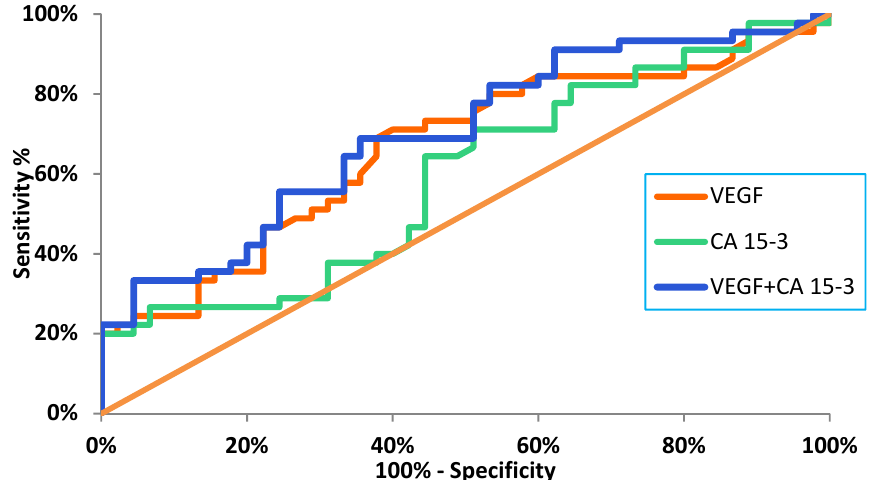
Figure 5. Diagnostic power of tested parameters in the diagnosis of breast cancer recurrence.